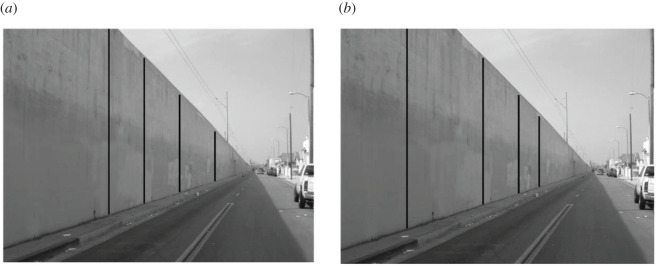
Demonstration of the Thouless-type regression to the real object when judging interval equidistance of lines superimposed on a perspective pictorial image. The required equidistance judgement is to determine if the separations between the four lines on the 2D plane of the page (ignoring the 3D pictorial content) are equal. (a) The intervals are equidistant on the 2D plane of the surface of the photograph but are typically perceived to be non-equidistant. (b) The spacing consistent with correct equidistant spacing in 3D pictorial space. Images adapted from Fig. 5 in Erkelens [47].